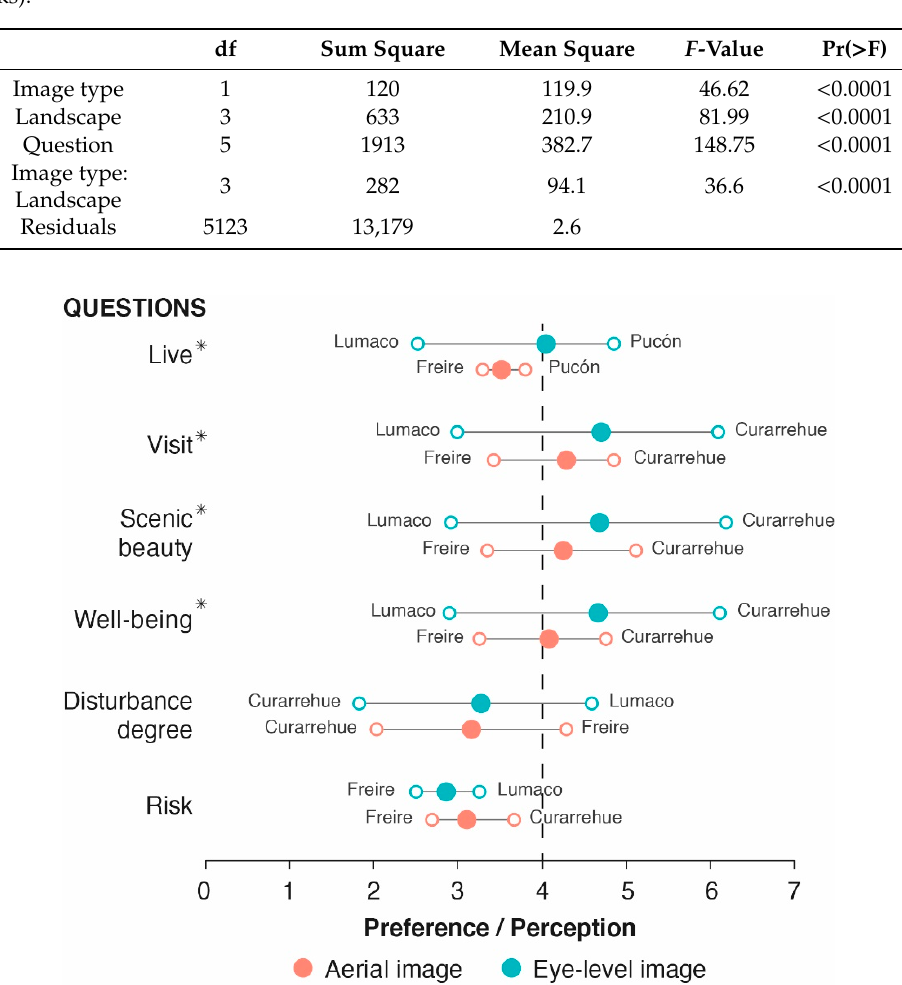
Table 2. Randomized Block ANOVA comparing image types and landscapes for six preference questions (blocks).